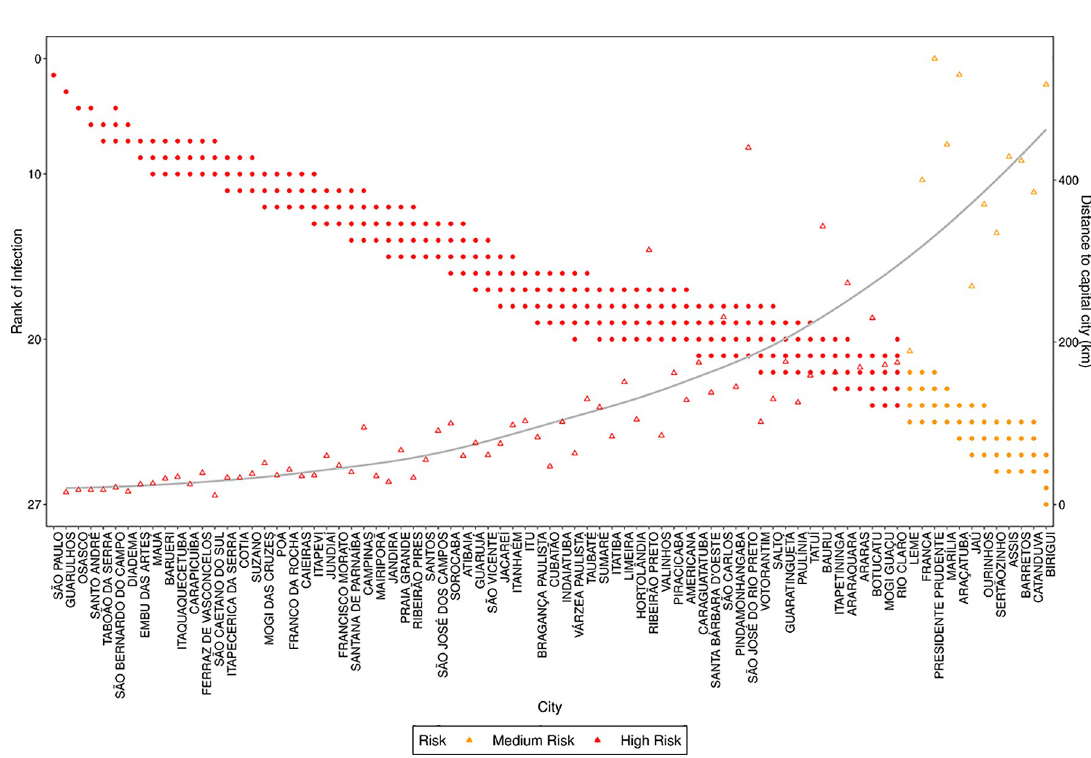
Fig 12. Rank of infection and distance to capital city for each city with more than 100,000 inhabitants in the state of S ã o Paulo. The points refer to ranks estimated for different values of s , the triangles to the distance to the capital city and the line is a smooth approximation of the distance triangles. The colors refer to the risk evaluated by k-means clustering of the ranks attributed by the simulated models.